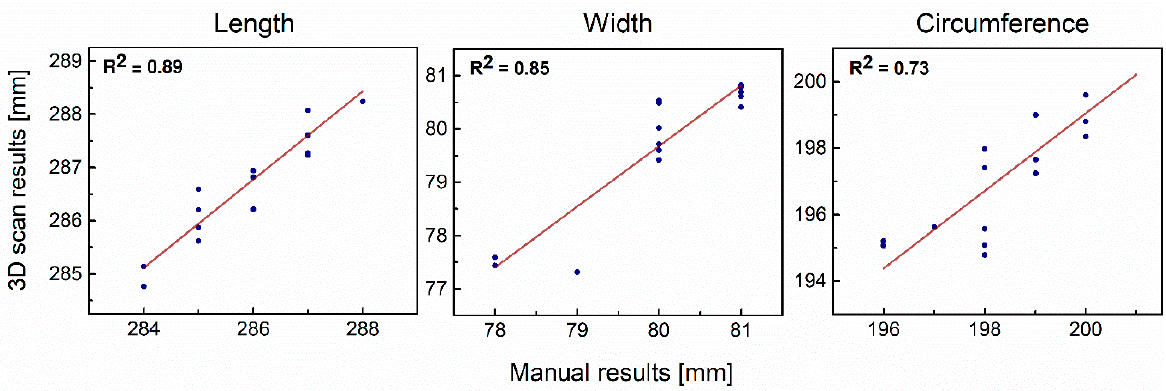
Figure 4. Linear relationship between manual and 3D scan results for length, width and circumference. In this study, the dimensional allowances (DAs) were calculated as the differences between the bare and gloved hand for three anthropometric parameters, i.e., t length, width and circumference. For this purpose, the aforementioned dimensions for the bare and gloved hand were measured using the selected software, according to the landmarks positions specified in Table 1. The mean numerical values of performed measurements with SD are presented in Table 3. Table 3. Mean values from 3D scan analysis with corresponding standard deviation for the bare and gloved hand.